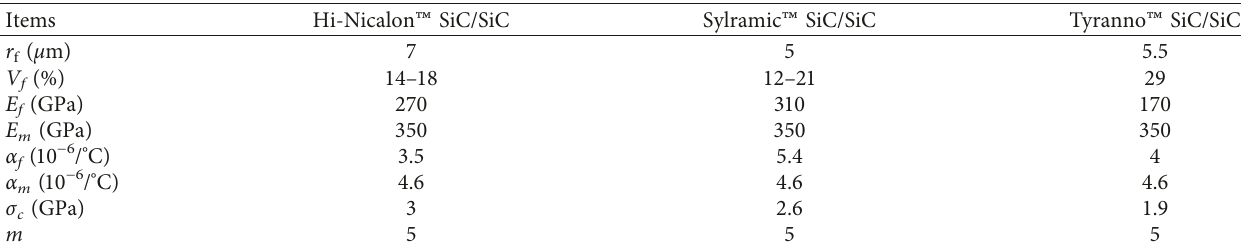
Figure 6: (a) The initial interface debonding stress and complete interface debonding stress versus the interface debonding energy curves; (b) the fatigue hysteresis dissipated energy versus the interface debonding energy curves; (c) the fatigue hysteresis modulus versus the interface debonding energy curves; (d) the fatigue hysteresis width versus the interface debonding energy curves for different fiber volume. Table 1: Material properties of 2D SiC/SiC